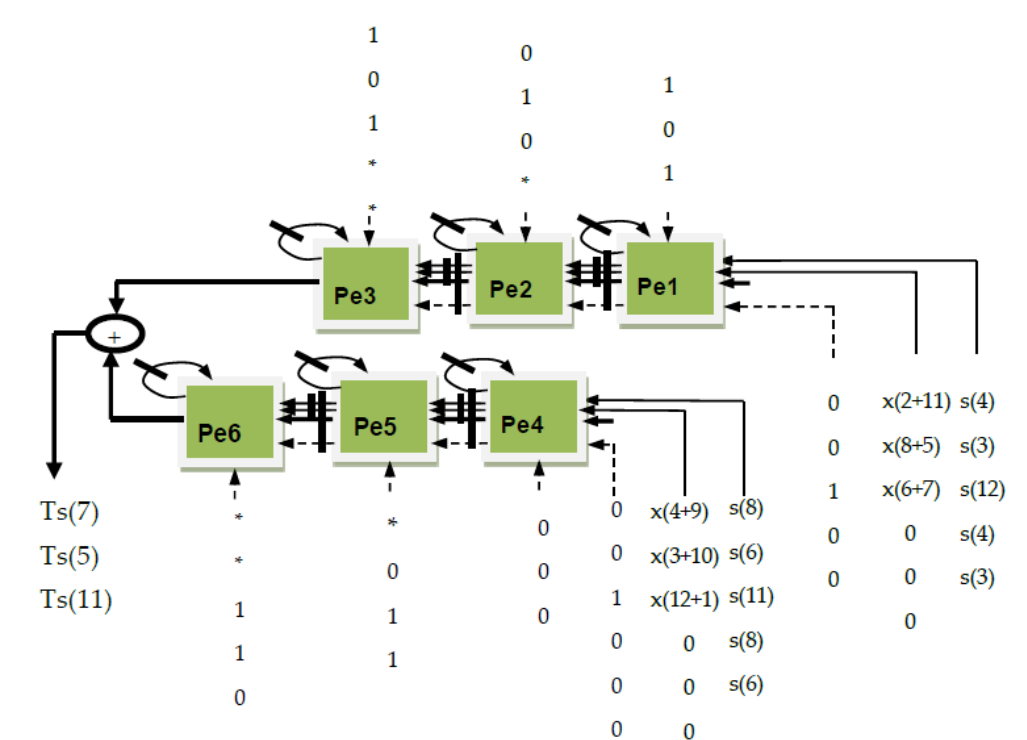
Electronics 2021 , 10 , x FOR PEER REVIEW Figure 9. The VLSI architecture of the hardware core that implements Equation (32), where * marks a delay of one clock cycle. In Figure 10 we have mapped Equation (33), resulting in the systolic array from be- low. We can see that the architecture presented computes the auxiliary output sequences Ts(9), Ts(3) and Ts(1), using the auxiliary input sequences x(4 + 9), x(3 + 10), x(12 + 1), x(2 + 11), x(8 + 5) and x(6 + 7) of the DST-IV transform.